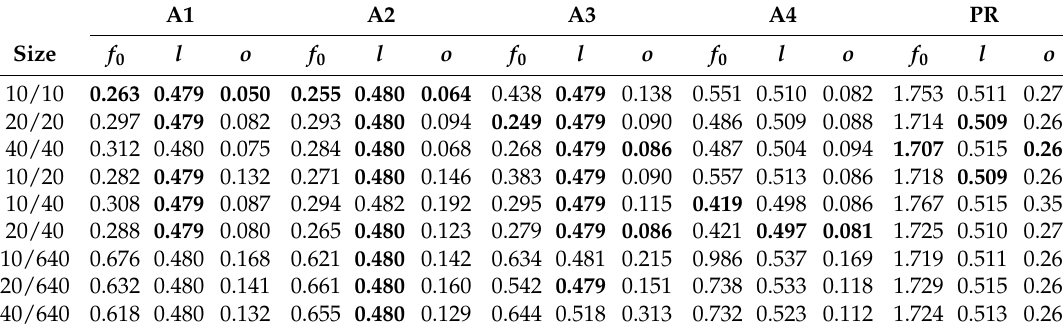
Table 1. The cross-entropy loss on validation data of models with varying window sizes, for each of the datasets (A1–4 and PR), and each of the three audio descriptors pitch, level, and onset. The first column specifies the compressed and expanded window sizes of the